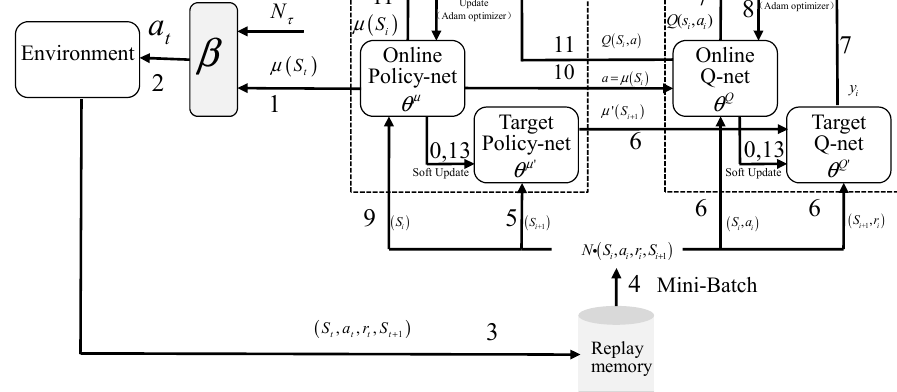
Figure 4. The block diagram of the DDPG algorithm.